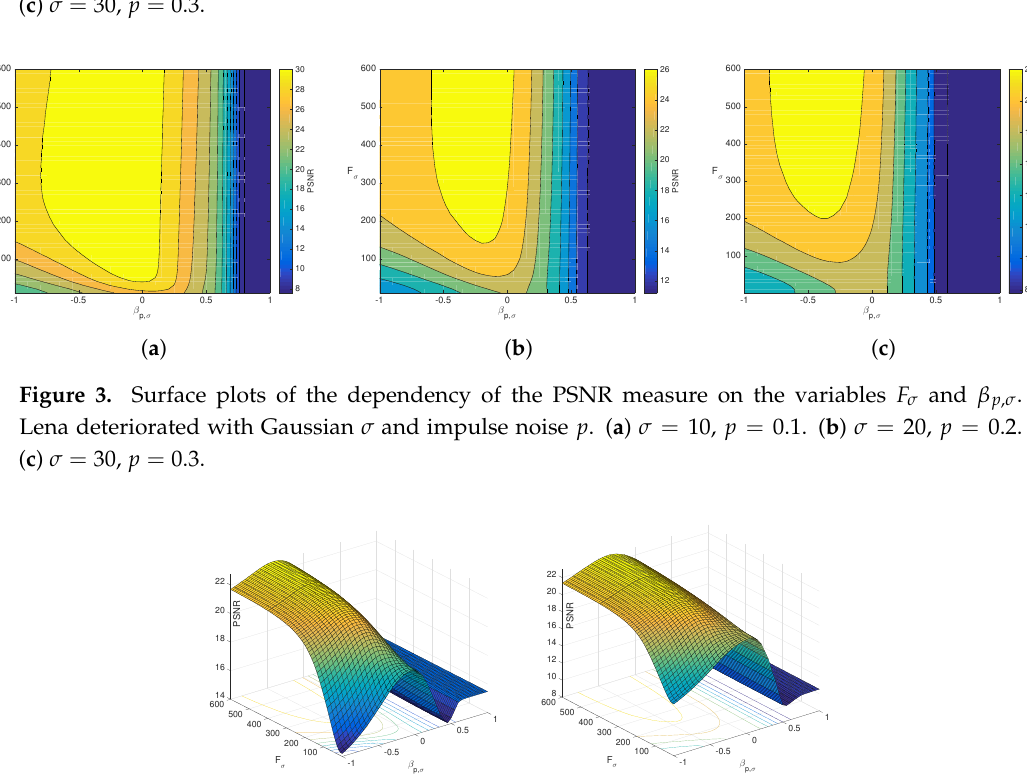
Figure 2. Dependency of the peak signal to noise ratio (PSNR) measure on the variables F σ and β p , σ . Lena deteriorated with Gaussian σ and impulse noise p . ( a ) σ = 10, p = 0.1. ( b ) σ = 20, p = 0.2. ( c ) σ = 30, p = 0.3.